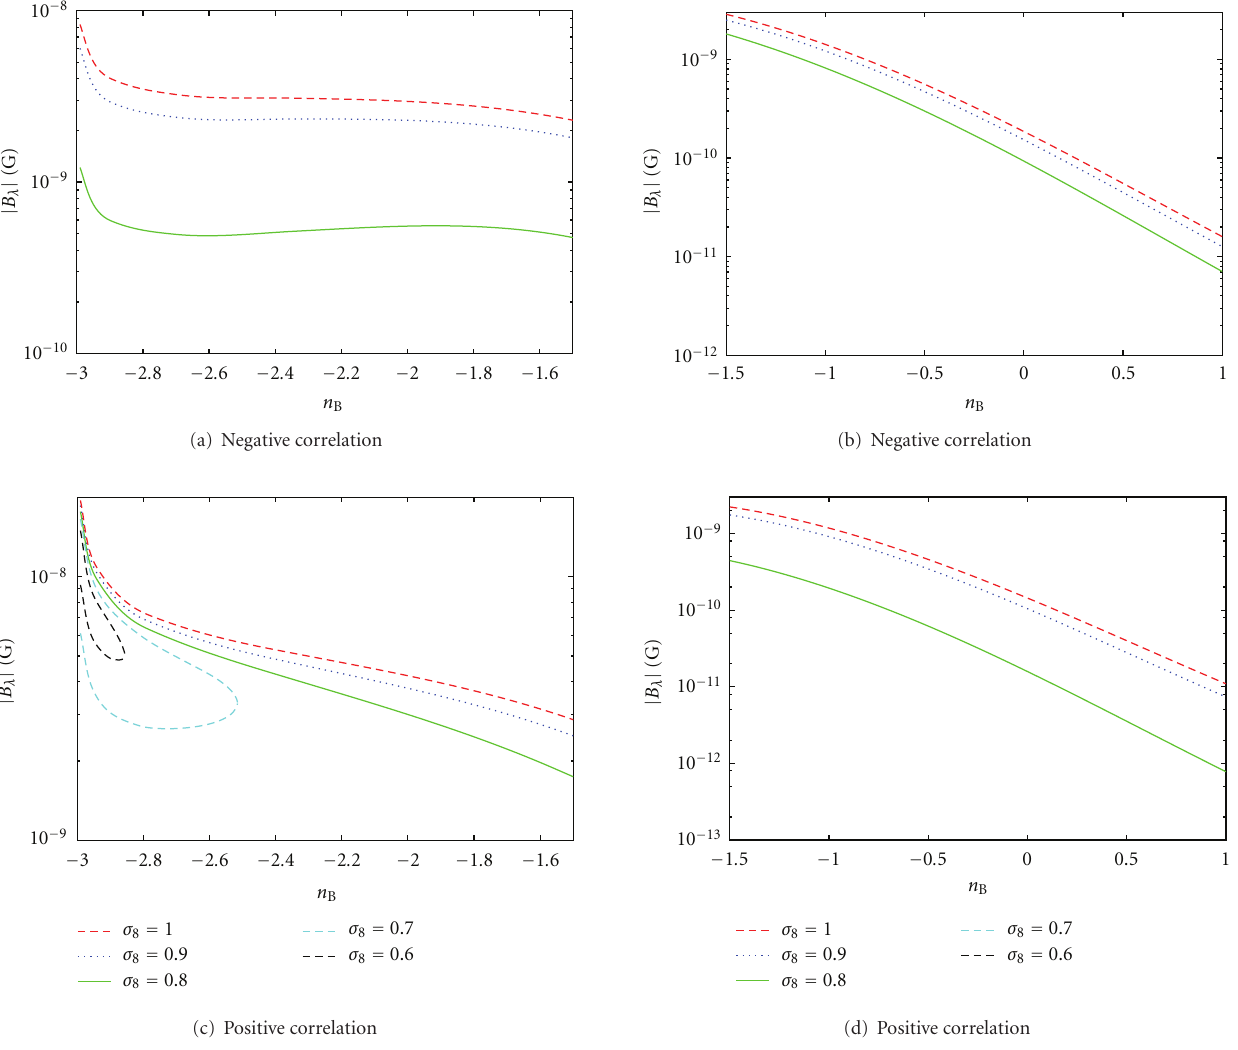
Figure 8: Curves of constant values for the σ 8 in the parameter plane of PMF amplitude B λ versus spectral index n B for the negative ( s [DF] = − 1) and positive ( s [DF] = 1) correlations between the PMF and the matter density fluctuations. Panels (a) and (c) show n B < − 1 . 5 as the PMF pressure-dominated region. On the other hand, panels (b) and (d) show n B > − 1 . 5 as the PMF tension-dominated region. Red-dashed, blue-dotted, green-bold, azure-dotted thin, and black-dashed thin curves show constant values of σ 8 = 1 . 0, 0 . 9, 0 . 8, 0 . 7, and 0.6,